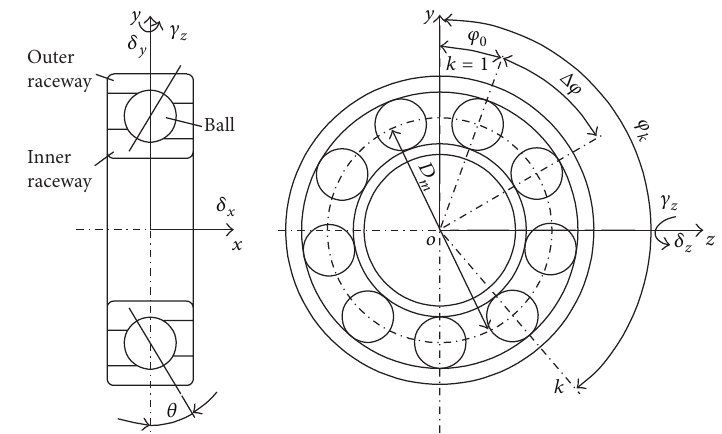
Figure 1: Geometric drawing of rolling bearings.